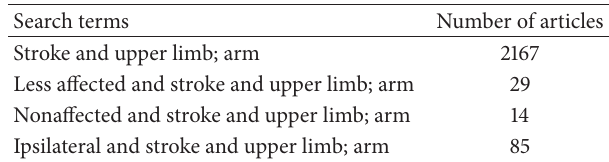
Table 2: Example search methodology: Embase from 1974 till present. Search